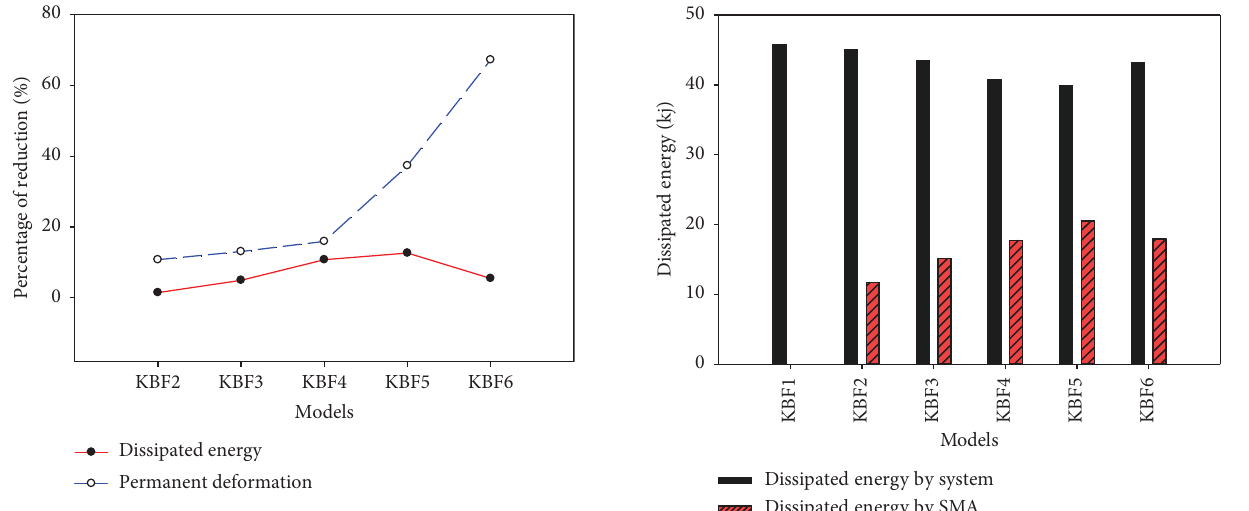
Figure 20: Te comparison of reduction in energy dissipation capacity and permanent deformation. Figure 21: Te contribution of the SMA damper in energy dis- sipation of the proposed KBF